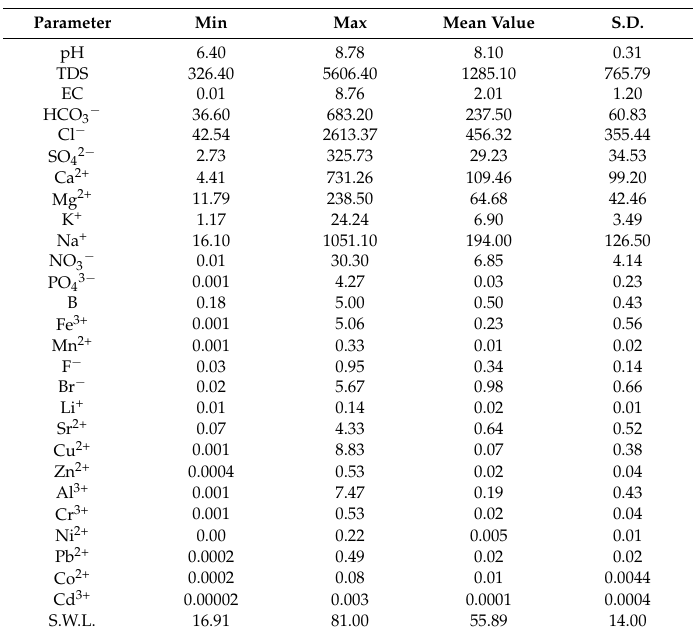
Table 1. Statistical summary of hydrochemical parameters of groundwater.